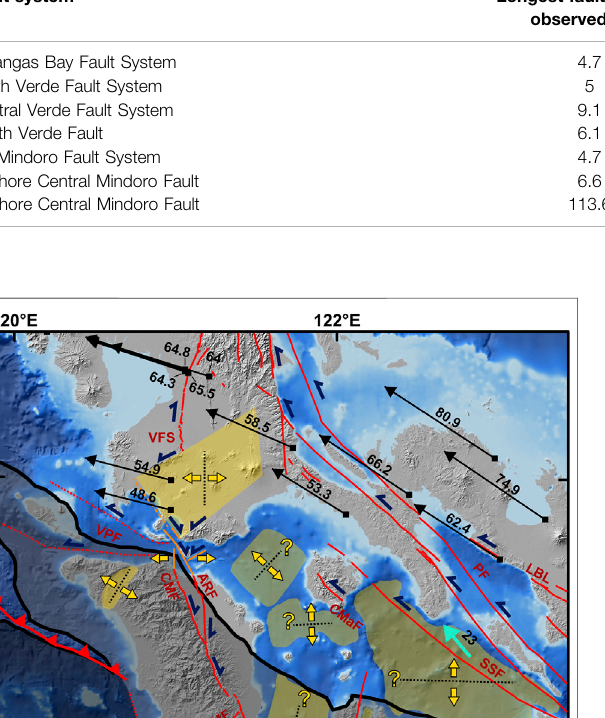
arrows are from Rangin et al. (1999), all fi xed to Sundaland Block in mm/yr. A lightblue arrow indicates GPS-derived slip (mm/yr)of Sibuyan Sea Fault (SSF)